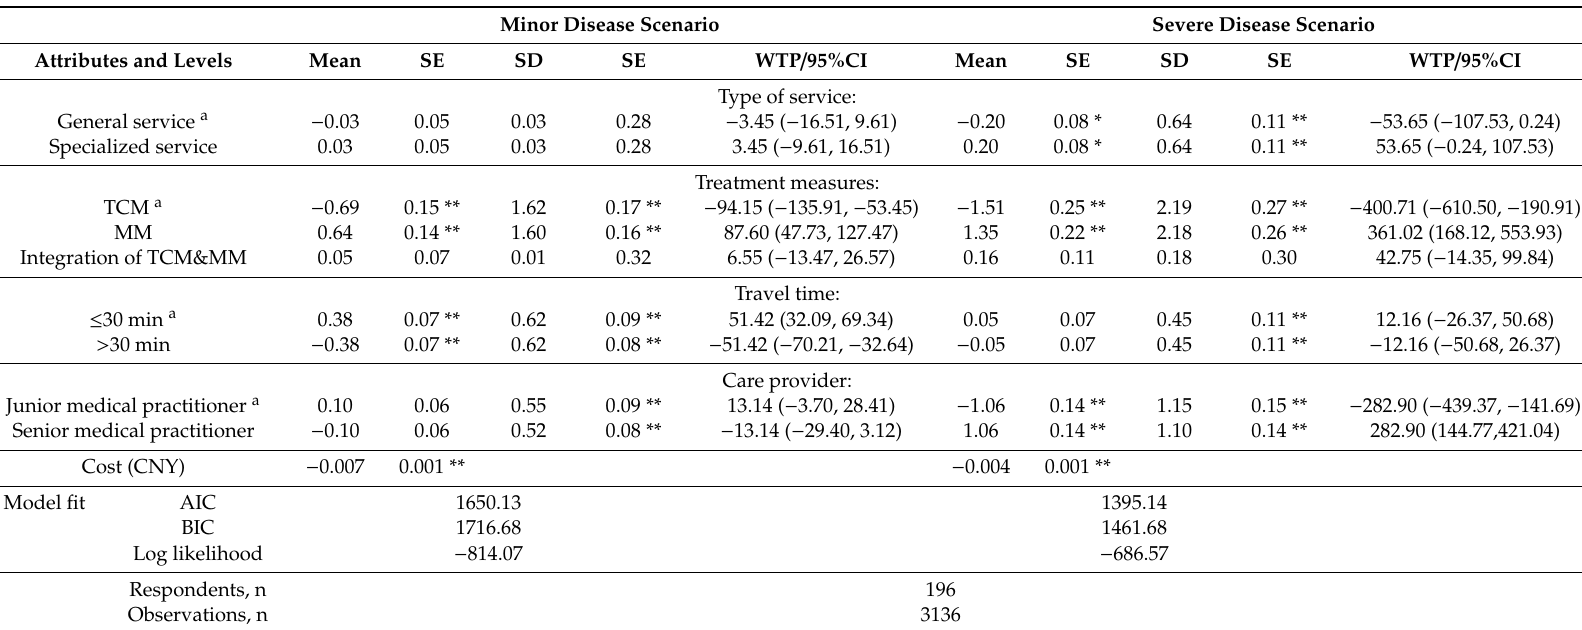
Table 3. Mixed logit main-e ff ect model estimates and willingness to pay in hypothetical minor disease and severe disease scenarios. Minor Disease Scenario Severe Disease